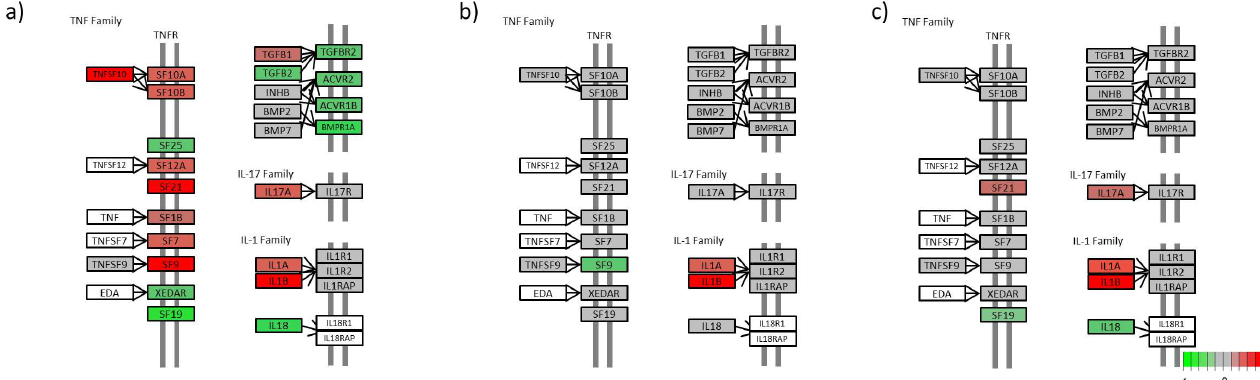
Fig 7. Cytokine-cytokine receptor interaction for the TNF family, IL-17 family and IL-1 family. (a) Untreatedlesionalversus nonlesional,(b) Untreatedlesionalversus 4 days after adalimumab treatment was initiatedand (c) Untreatedlesionalversus 14 days after adalimumab treatment was initiated. (Colours refer to the expressionlevel; green is downregulated, red is upregulatedin untreatedlesionalpsoriatic skin, grey is not regulatedand white is not includedin our data set) (Please find list of gene names in S4 Table).